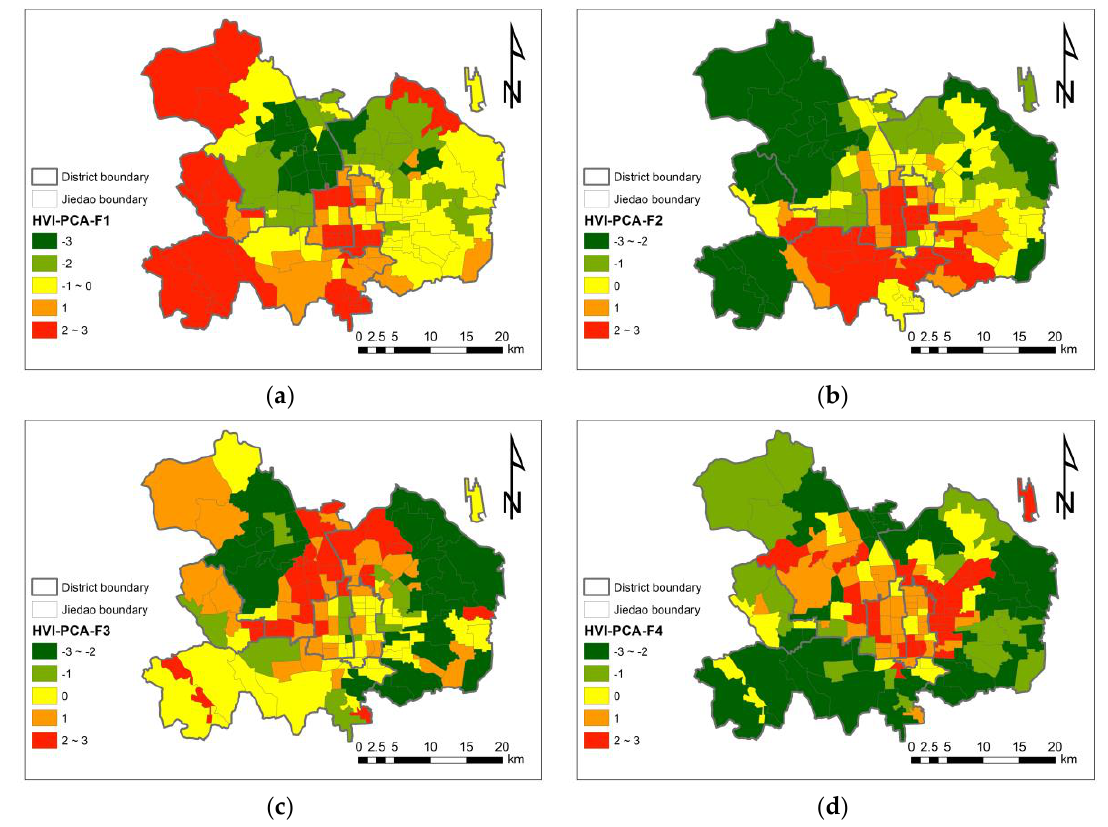
Figure 4. Spatial pattern of four factors for heat vulnerability using the PCA approach. Factor 1: illiteracy / unhealthy / air conditioners / income ( a ); Factor 2: LST / NDVI ( b ); Factor 3: living alone / below high school education / college education or above ( c ); Factor 4: population < 5 / population ≥ 65 ( d ).